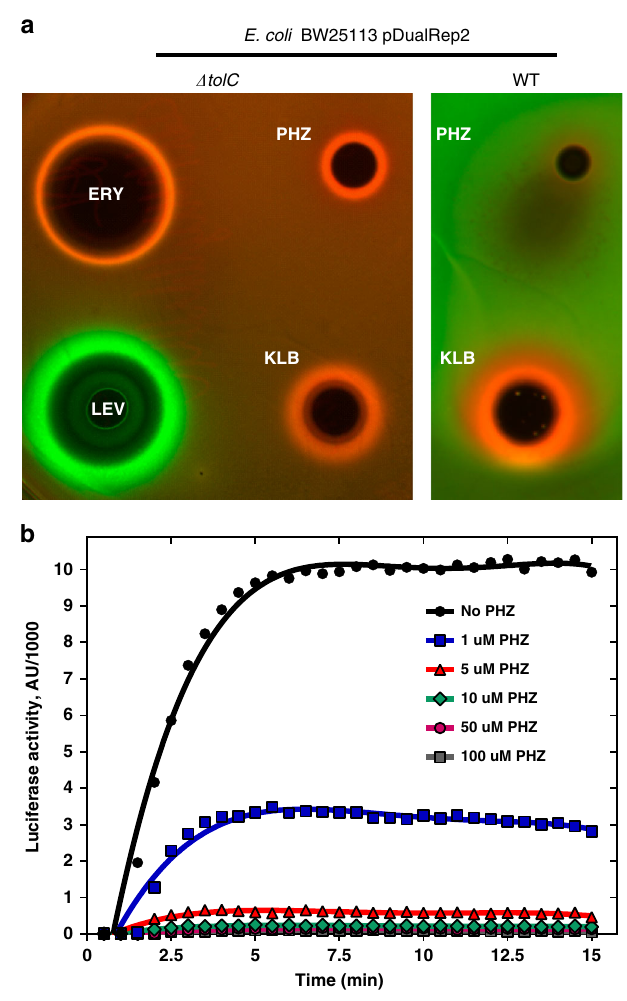
Fig. 2 Phazolicin is an inhibitor of protein synthesis both in vivo and in vitro. a In vivo testing of PHZ activity using BW25113 Δ tolC pDualRep2 and BW25113 pDualRep2 (WT) reporter strains. The induction of RFP expression (green halo around the inhibition zone, pseudocolors) is triggered by DNA-damage while the induction of Katushka2S protein (red halo) occurs in response to ribosome stalling. Erythromycin (ERY), levo fl oxacin (LEV), and klebsazolicin (KLB) are used as controls. b Kinetic curves showing inhibition of protein synthesis by increasing concentrations of PHZ in the in vitro cell-free translation in E. coli S30 extract.